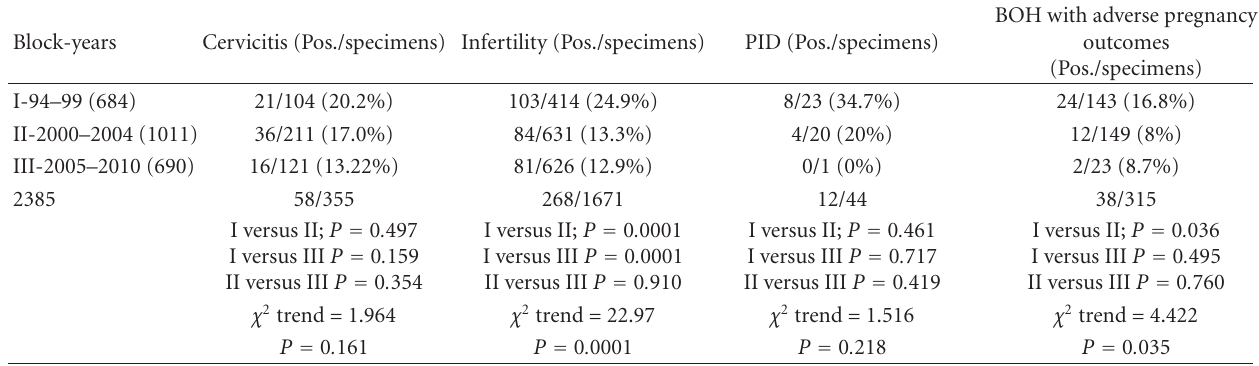
Table 1: Antigen positivity in patients of various disease groups from 1994 to 2010.